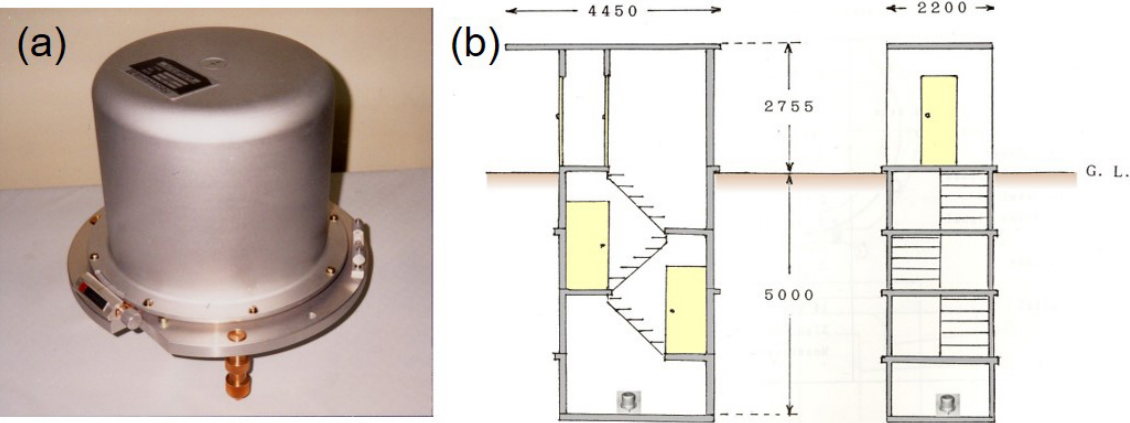
Figure 29. (a) FM90, the fluxgate magnetometer with level meters. (b) Cross sections of the observation hut which was constructed for the fluxgate magnetometer. The fluxgate magnetometer is installed at a depth of 5m (photo and document supplied by Kakioka Magnetic